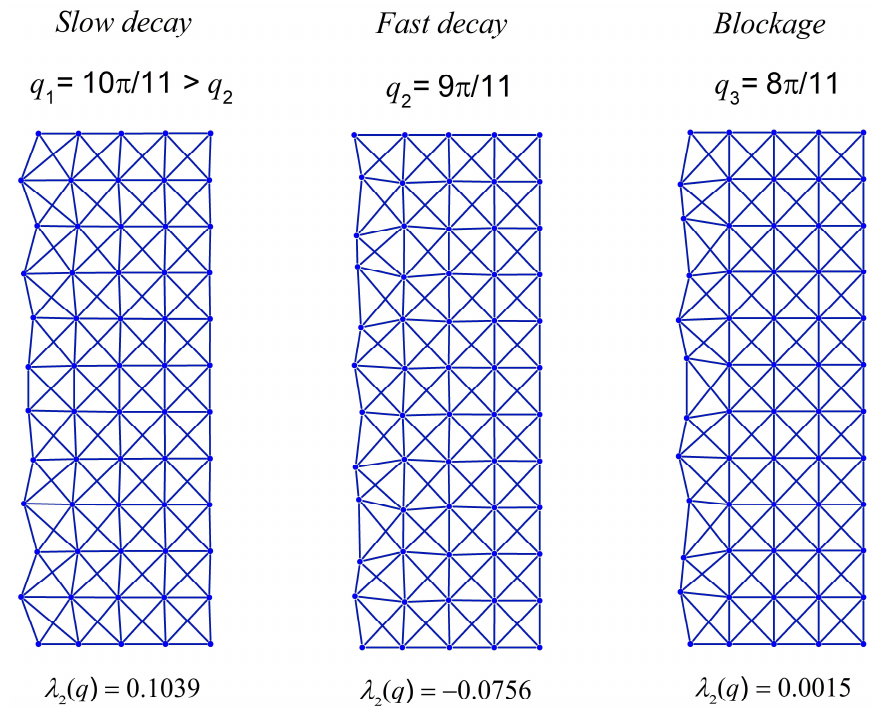
Figure 7. Deformation configuration (scaled) of the analytical solutions (Equations (34)–(36)), respectively, for half-cyclic domain of an x-braced lattice ( k = 0.93, m = 0 → 11, n = 0 → 4 ).